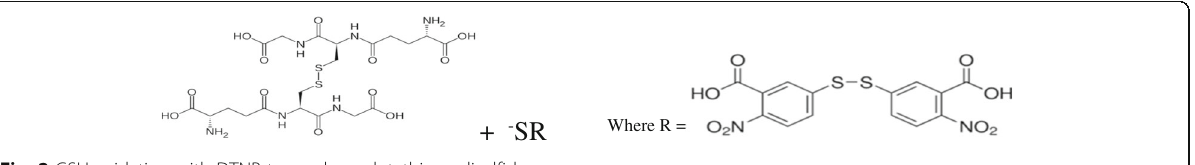
Fig. 2 GSH oxidation with DTNB to produce glutathione disulfide